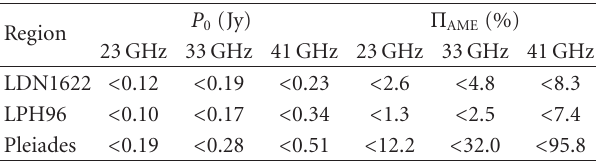
Table 4: Upper limits at the 95% confidence level, on the fractional linear polarisation of the AME measured in LDN1622, LPH96, and Pleiades at the three lowest WMAP frequency